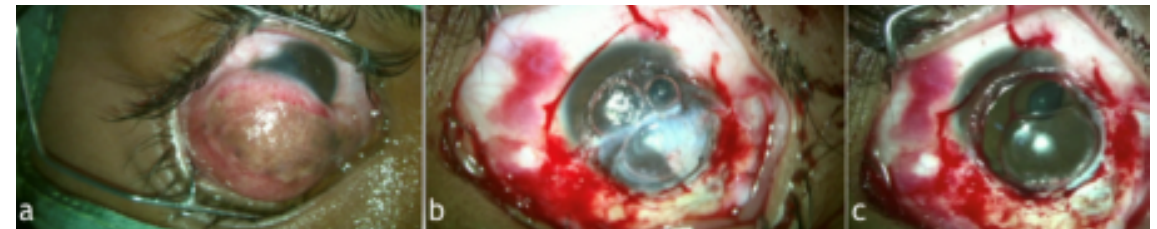
Figure 2: Intra-operative pictures showing (a) limbal dermoid sparing superior one-third of the cornea; (b) deeper involvement of corneal layers visualized after dermoid excision; (c) Descemet’s membrane was exposed after manually dissecting deeper stromal layers.